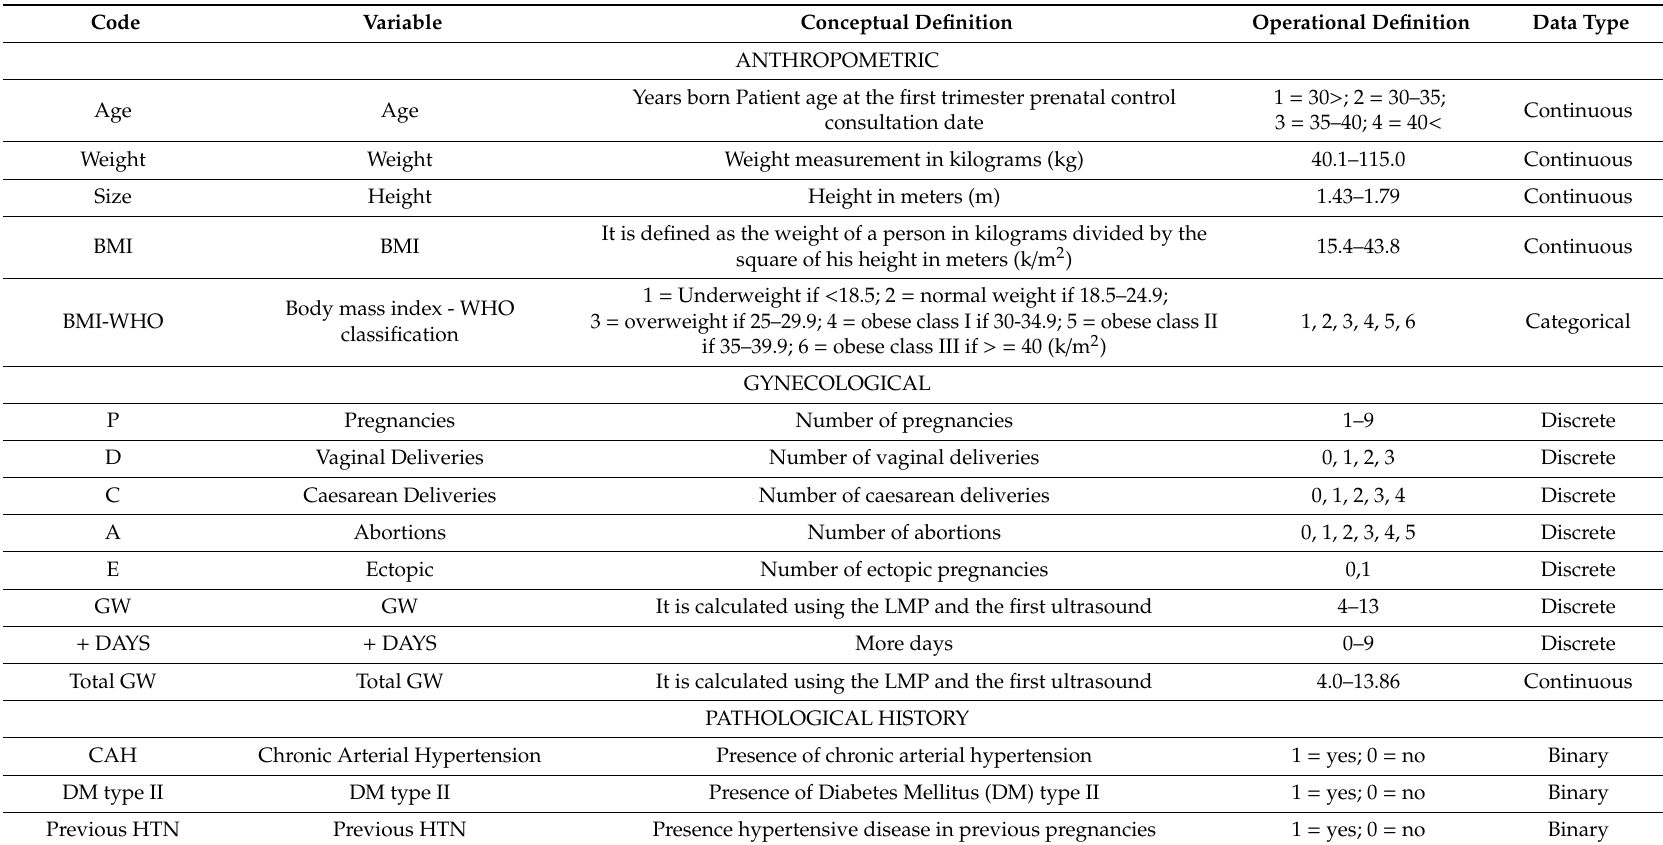
Table 1. Women in first trimester of pregnancy